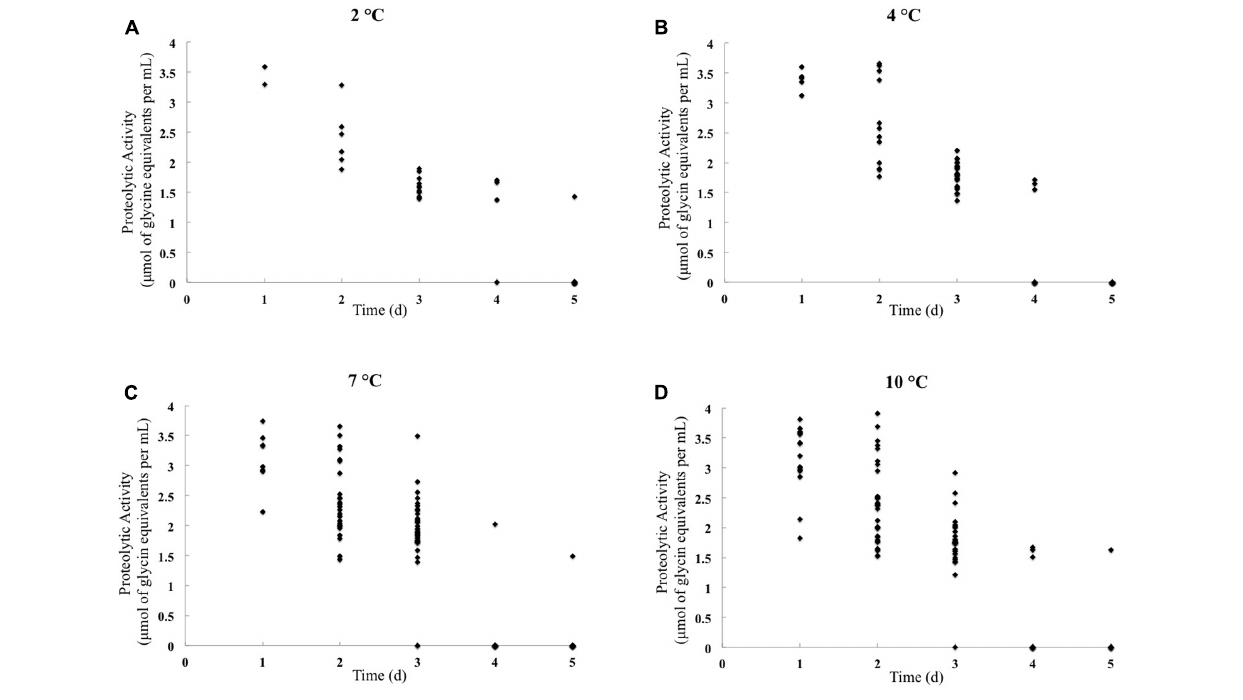
FIGURE 1 | Proteolytic activity quantification of Pseudomonas isolates obtained from raw cow milk samples stored for 5 days at 2 ◦ C (A) , 4 ◦ C (B) , 7 ◦ C (C) , and 10 ◦ C (D) . The X -axis represents the storage day when the isolates displayed extracellular peptidase activity on milk agar, and the Y -axis represents proteolytic activity ( µ mol of glycine equivalents per mL). Species names and isolate numbers are not